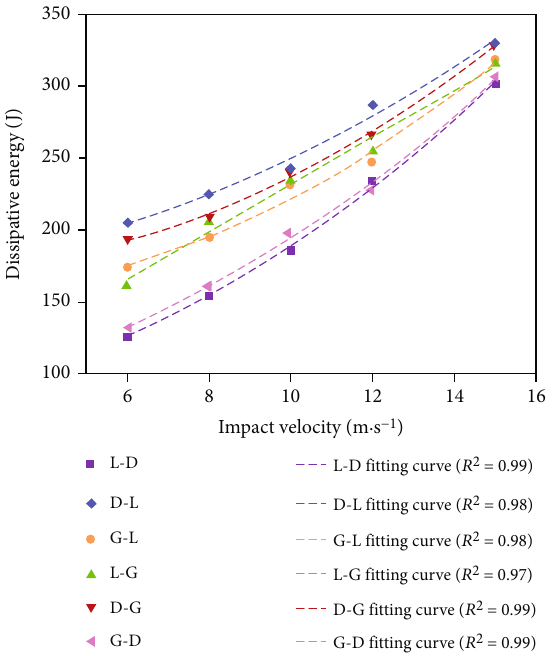
Figure 6: The relationship between dissipated energy and impact.